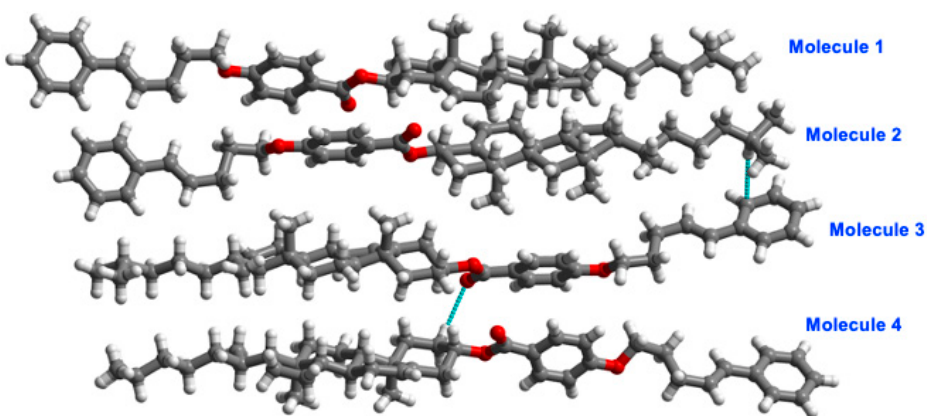
Figure 2. View of independent molecules in the unit cell of M5 . Intermolecular contacts are shown as dotted blue lines. Color codes: H white; C gray; O red; B orange.